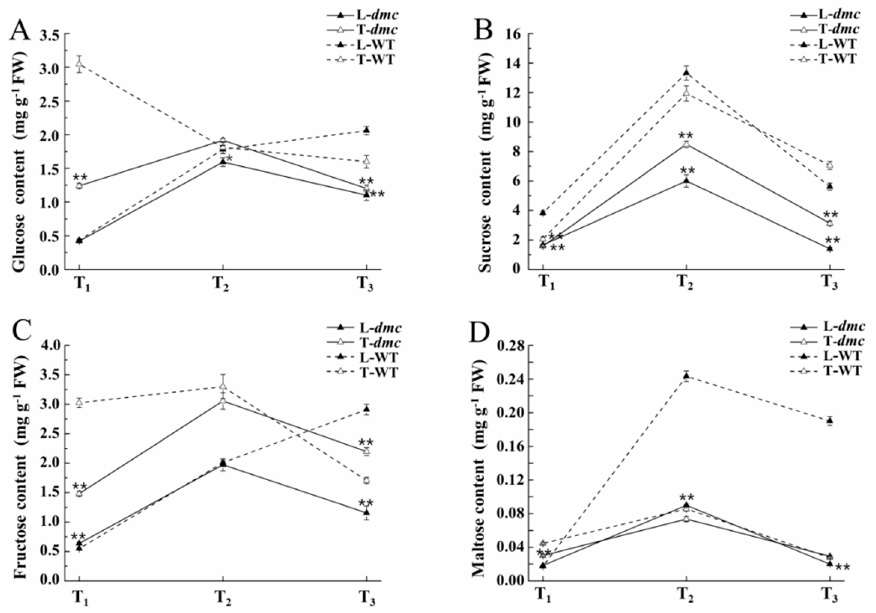
Figure 7. The carbohydrate contents in leaves and tiller nodes of dmc and WT. ( A ) Glucose content; ( B ) Sucrose content; ( C ) Fructose content; ( D ) Maltose content; L-WT: WT leaves; T-WT: WT tiller nodes; L- dmc : dmc leaves; T- dmc : dmc tiller nodes; T 1 : three-leaf stage; T 2 : over-winter stage; T 3 : between the rising to jointing stage.